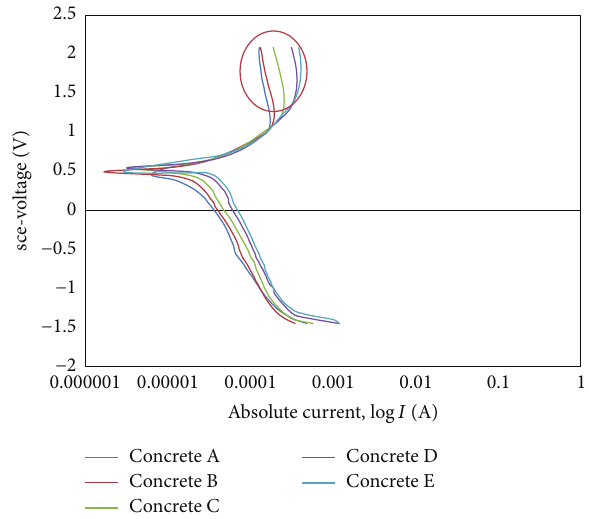
Figure 4: Polarization scan of rebar in 3.5% NaCl solution after immersion for 365 days.